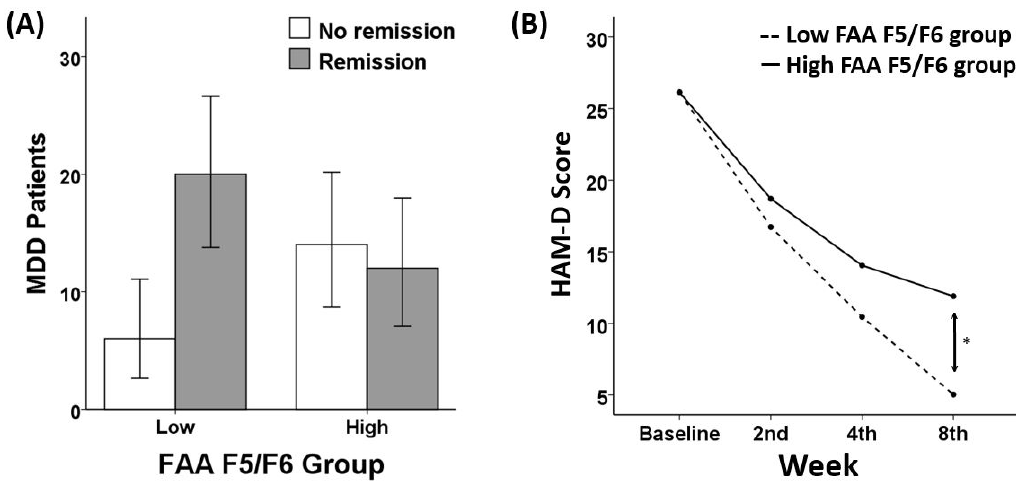
Figure 1. ( A ) Remission ratio by frontal alpha symmetry (FAA) F5 / F6 groups (chi-square = 5.20, p = 0.023) and ( B ) treatment responsiveness in HAM-D score over the eight weeks by Low and High FAA F5 / F6 groups (rANOVA: F (2.560, 117.755) = 3.84, p = 0.016). One-way ANCOVA showed a significant di ff erence in HAM-D score between Low and High FAA group at 8th clinical benchmark, p = 0.009.